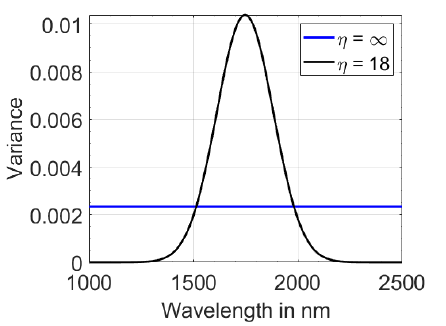
Figure 4. The noise variance along the spectral bands at SNR = 25